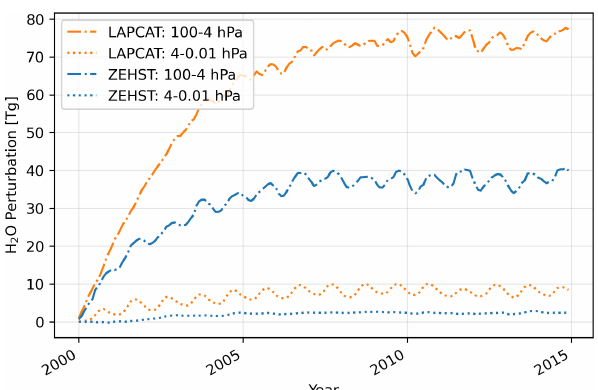
Figure A2. Timeline plot of accumulated trace gas H 2 O in teragram, based on monthly mean values. Blue lines represent scenario ZEHST and orange lines represent scenario LAPCAT. Shown is the H 2 O perturbation over time above 4hPa (dotted) and from 4–100hPa (solid-